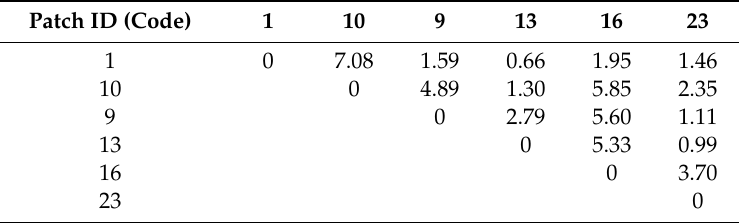
Table 6. Interaction matrix based on the gravity